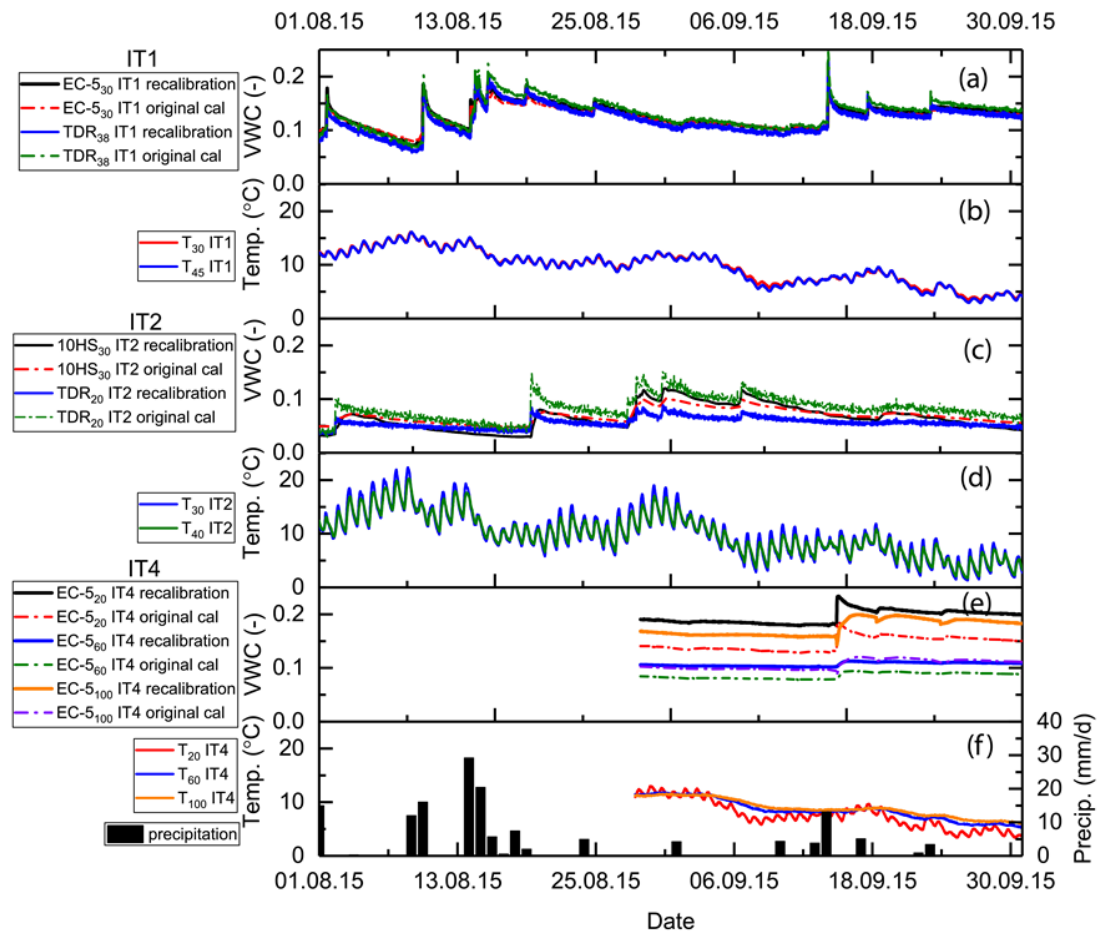
Figure 14. Data Period 4: 1 August 2015–30 September 2015. Site-specific calibration: comparison between data based on original calibration and the recalibration for the summer period.